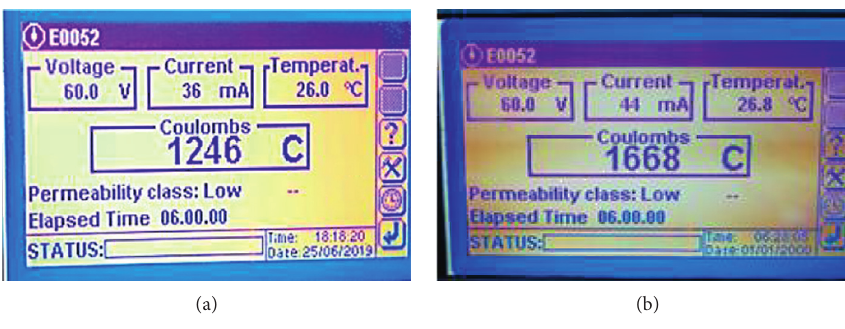
Figure 5: Specimen ready for